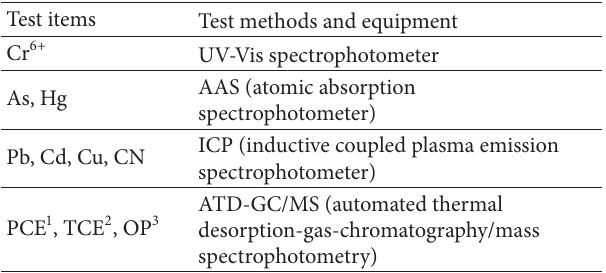
Table 3: Test method and equipment for detection analysis of harmful materials [12, 13].